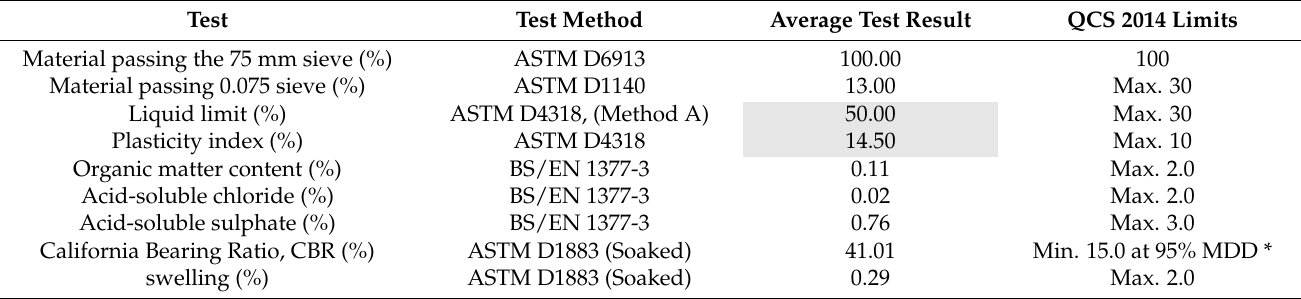
Table 5. Comparison between the properties of TBM muck and QCS 2014 (specifications of suitable road filling and subgrade